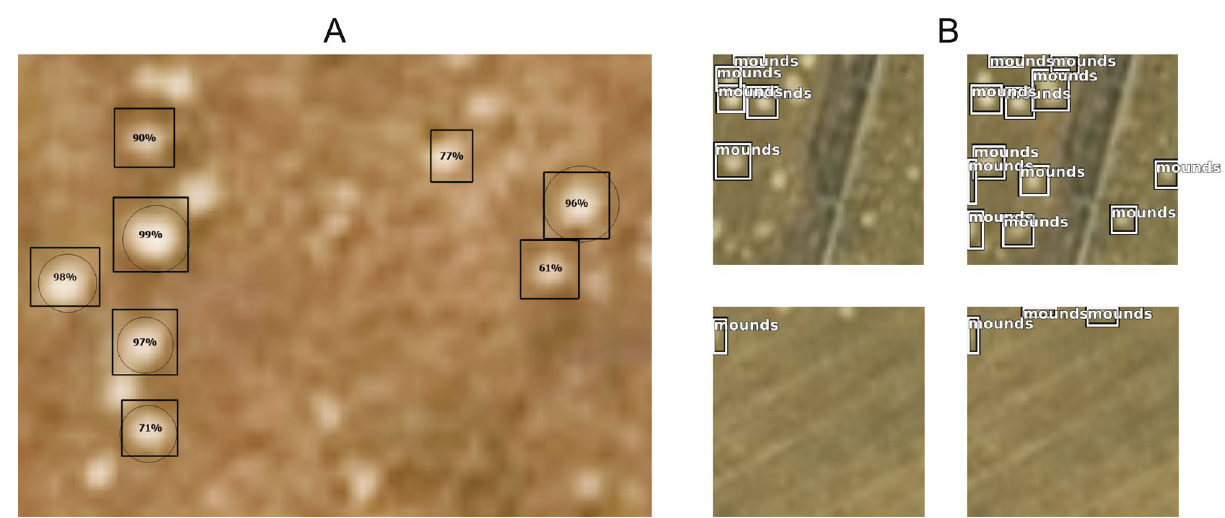
Figure 3. Examples of labelled mounds, precision score ( A ), and final results of mound recognition in four randomly selected sites ( B ). The figure was generated in ArcGIS Pro v2.8 (https:// www. esri. com) and CorelDRAW Standard 2020 (https:// www. corel.